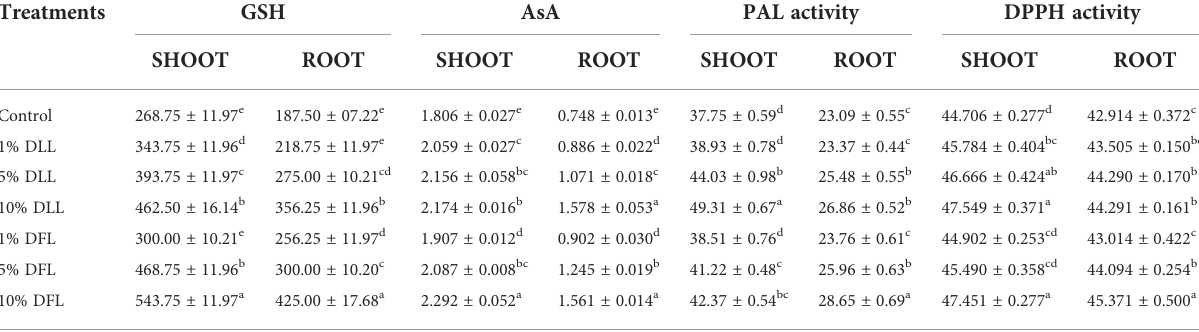
TABLE 2 Reduced glutathione (nM g -1 fr wt), ascorbic acid, total phenols, tannins (mg g -1 fr wt), phenyl alanine ammonia lyase (nM trans- cinnamic acid min -1 mg -1 protein), and total antioxidant (percent) activity in leaves of Triticum aestivum L. plants raised using sand substrate (25 DAS) treated with leachates of fresh leaves and fl owers of Tagetes erecta L.